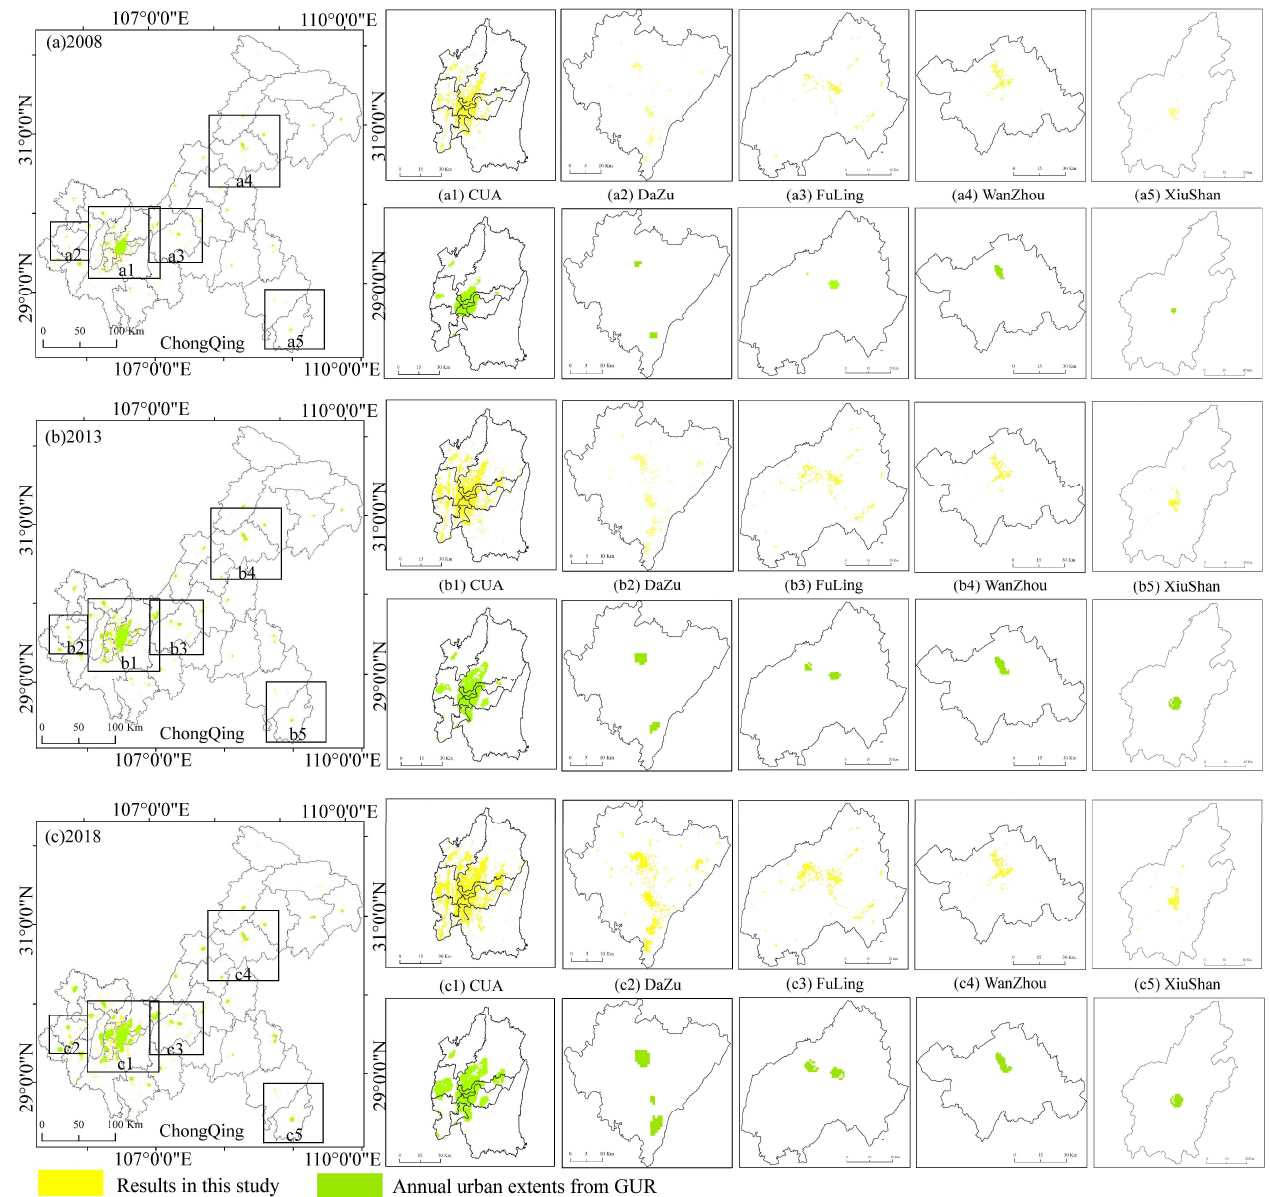
Figure 4. Comparison of the spatial range between the results of the built-up areas extracted in this paper and the dataset of the GUR. The spatial range comparison of the two datasets in 2008 ( a ), 2003 ( b ), and 2018 ( c ) in Chongqing. The comparison of the two datasets in CUA ( a1 , b1 , c1 ), Dazu ( a2 , b2 , c2 ), Fuling ( a3 , b3 , c3 ), Wanzhou ( a4 , b4 , c4 ), and Xiushan ( a5 , b5 , c5 ) in 2008, 2013, and